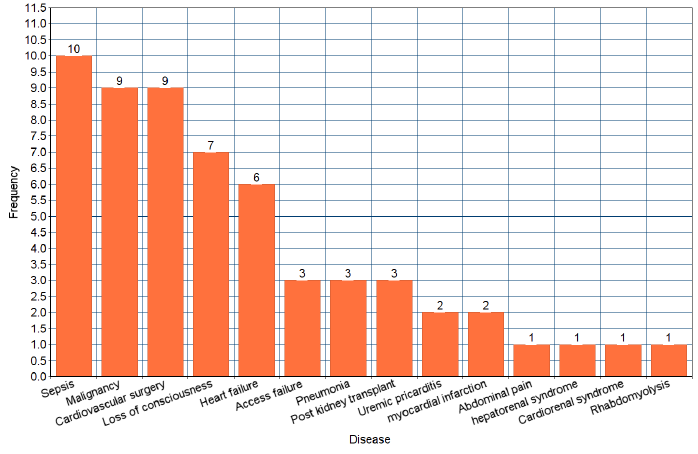
Figure 1. Diseases that cause initial admission by